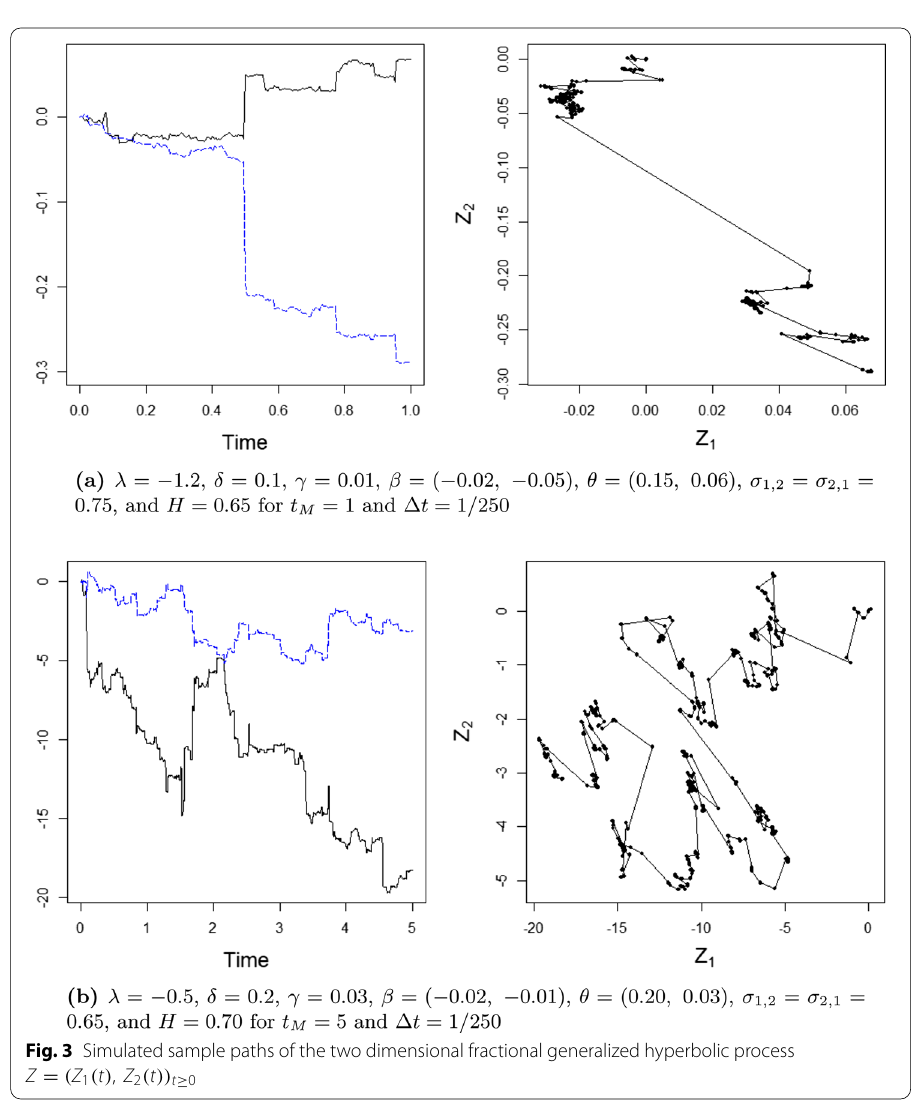
Fig. 3 Simulated sample paths of the two dimensional fractional generalized hyperbolic process Z = ( Z 1 ( t ) , Z 2 ( t )) t ≥